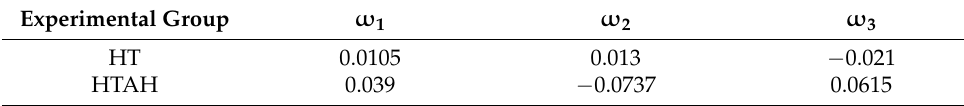
Table 5. ω i values in different environments ( i = 1 ∼ 3 ).